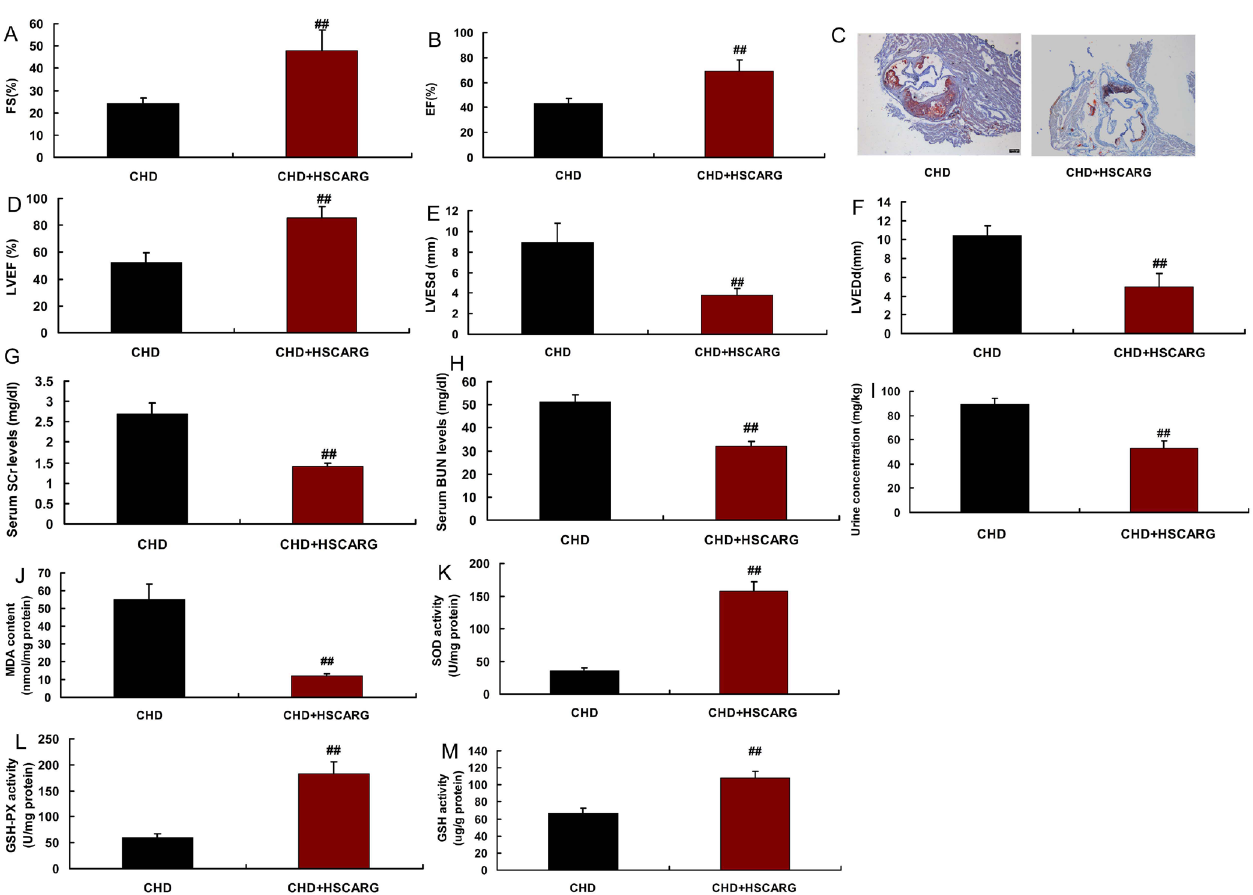
Fig. 2 - HSCARG reduced oxidative stress in mice model of atherosclerotic coronary heart disease (CHD). Fractional shortening (FS) (A), ejection fraction (EF) (B), plaque volume (hematoxylin and eosin staining) (C), left ventricular ejection fraction (LVEF) (D), left ventricular end-systolic diameter (LVESd) (E), left ventricular end-diastolic diameter (LVEDd) (F), serum creatinine (SCr) and blood urea nitrogen (BUN) (G and H), urine concentration (I), malondialdehyde (MDA) levels (J), superoxide dismutase (SOD), glutathione peroxidase (GSH-PX), and glutathione (GSH) levels (K, L, and M). CHD=mice model of CHD group; CHD+HSCARG=mice model of CHD treated by HSCARG protein group. ##P<0.01